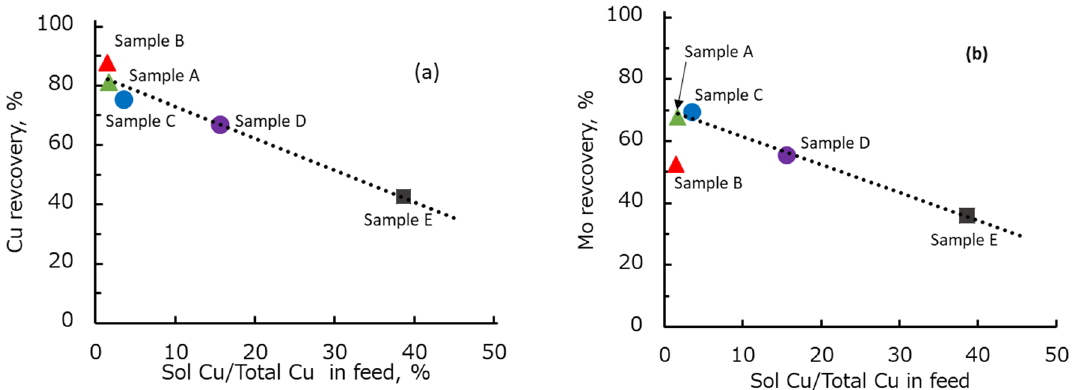
Figure 4. Relationships between copper oxidation degree and the recovery of copper ( a ) and molybdenum ( b ) in each ore.